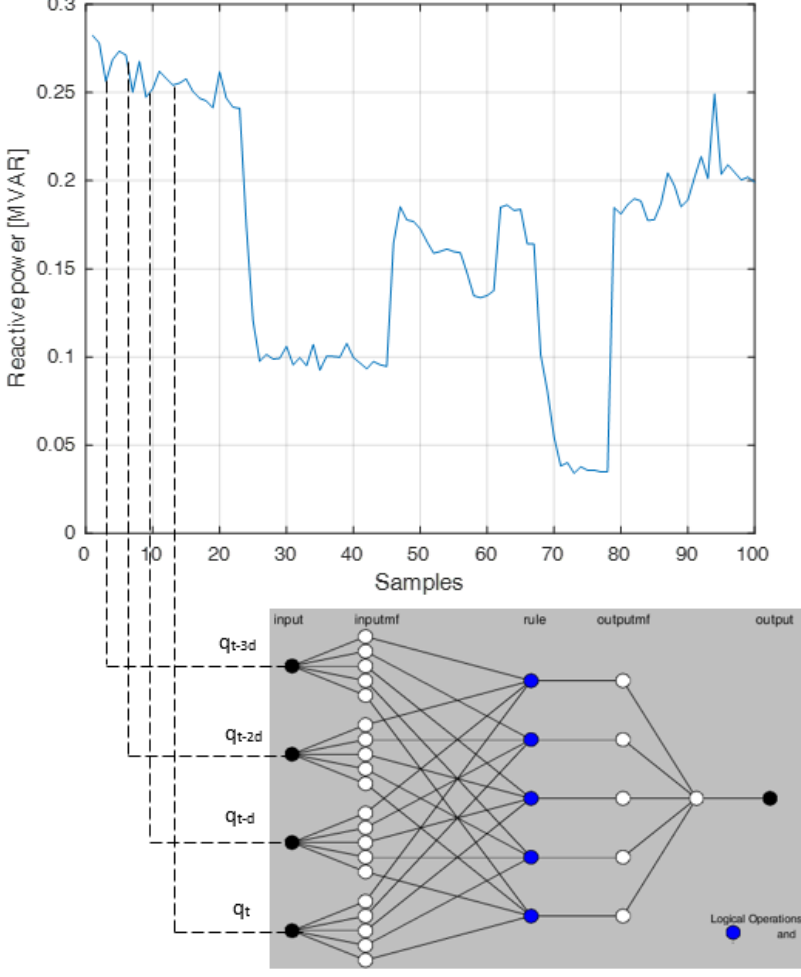
Figure 6. How to use previous samples of reactive power when modelling with ANFIS.